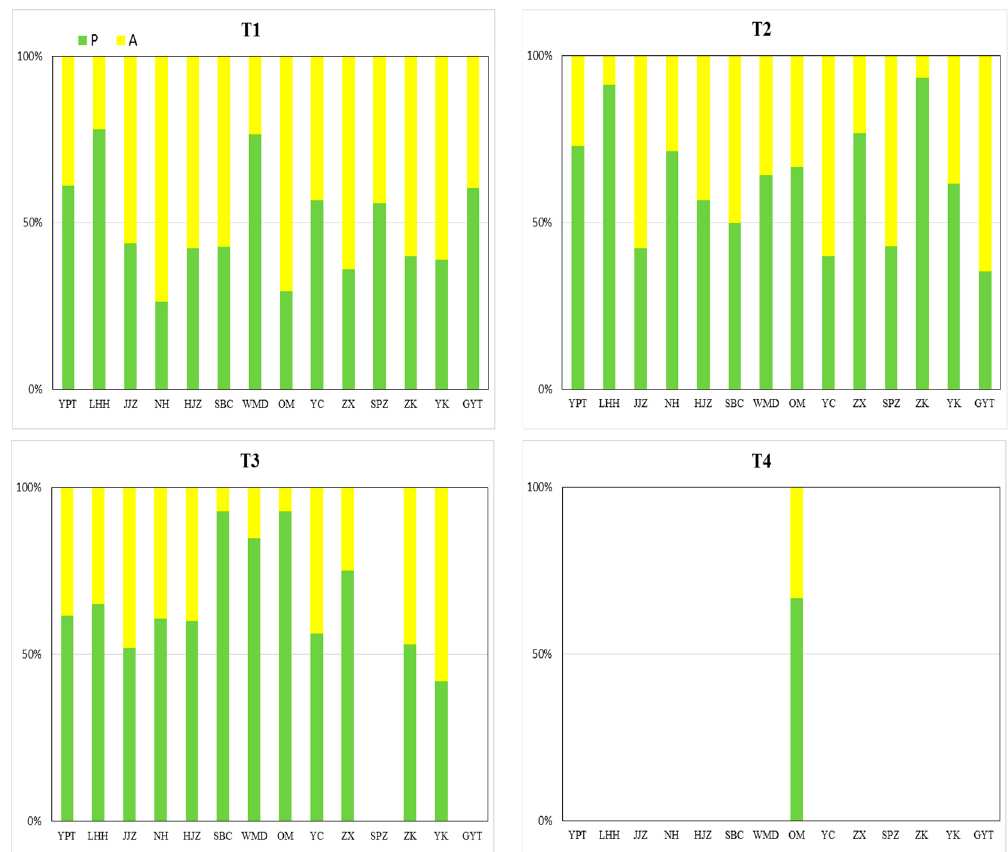
Figure 2. Plant hydrophilic types for four transects in each sampling site in the MLHR, China. Hy, hydric species; M, mesic species; Mp, mesophytes; and X, xerophytes. T1, 2, 3, and 4 represent the first, second, third, and fourth transect, respectively. YPT, Yangpitan; LHH, Lihuahu; JJZ, Jiangjia- zhou; NH, Nanhu; HJZ, Hujiazhou; SBC, Shanbiancun; WMD, Wumingdao; OM, Oumiao; YC, Yi- cheng; ZX, Zhongxiang; SPZ, Shipaizhen; ZK, Zekou; YK, Yuekou; GYT, Guanyintang.